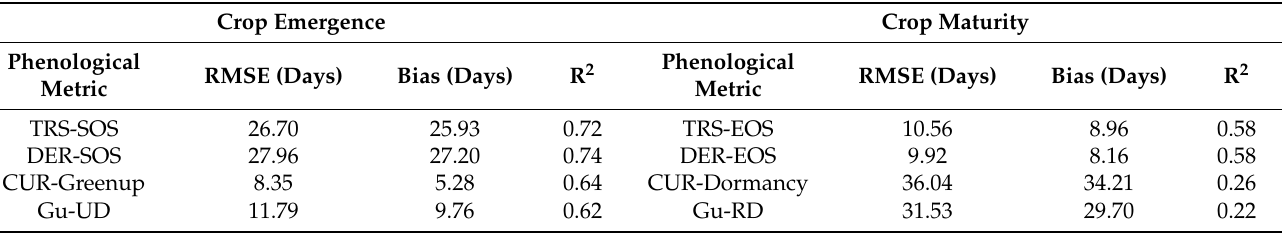
Figure 8. The comparisons between the PlanetScope NDVI-based transition date estimates of the greenness rising period and the visually observed emergence for ( a ) both corn and soybean, ( b ) corn, and ( c ) soybean, using the four phenophase analysis methods. Table 3. The accuracy statistics of comparisons between the PlanetScope NDVI-based transition date estimates and corresponding visual interpretations using all the PlanetScope site-year